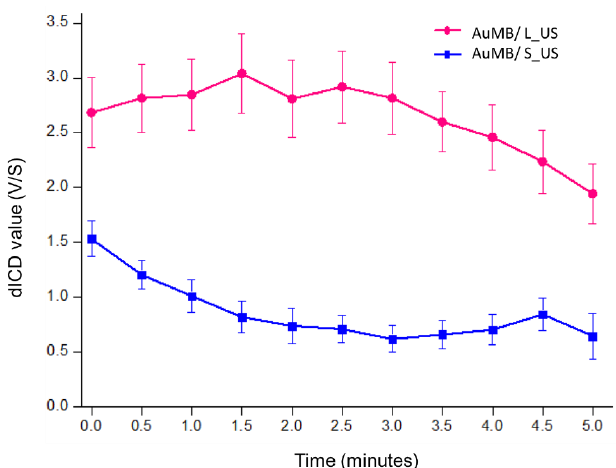
Figure 3. Differential inertial cavitation dose (dICD) values measured during 5 min of sonoporation with long-duration (pulse duration = 30 µs) and short-duration (pulse duration = 10 µs) acoustic stimulation. Data are mean and SD values.